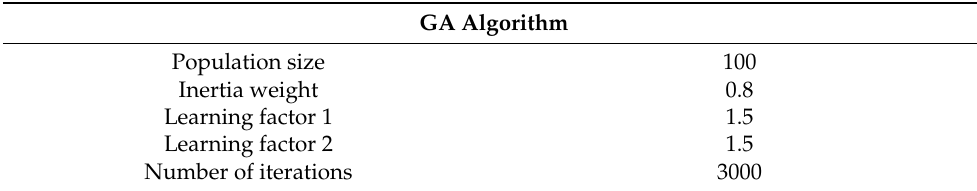
Table 3. Main parameters of PSO.